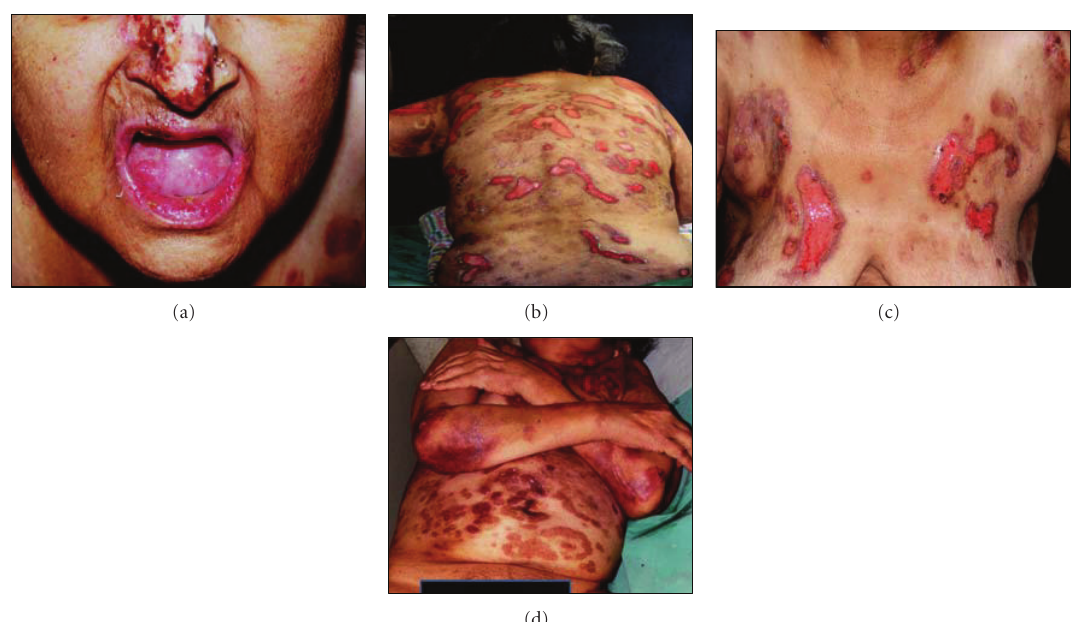
Figure 1: Severe erosions of vermilion lip and tongue, and nasal bridge (a), widespread crusted and denuded skin lesions over back (b), chest (c), abdomen and upper limbs (d).